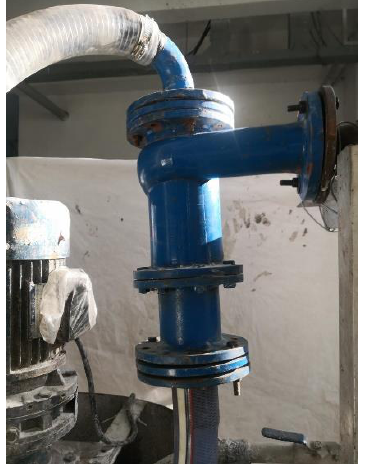
Figure 6. W-shaped hydrocyclone. Figure 6. W-shaped